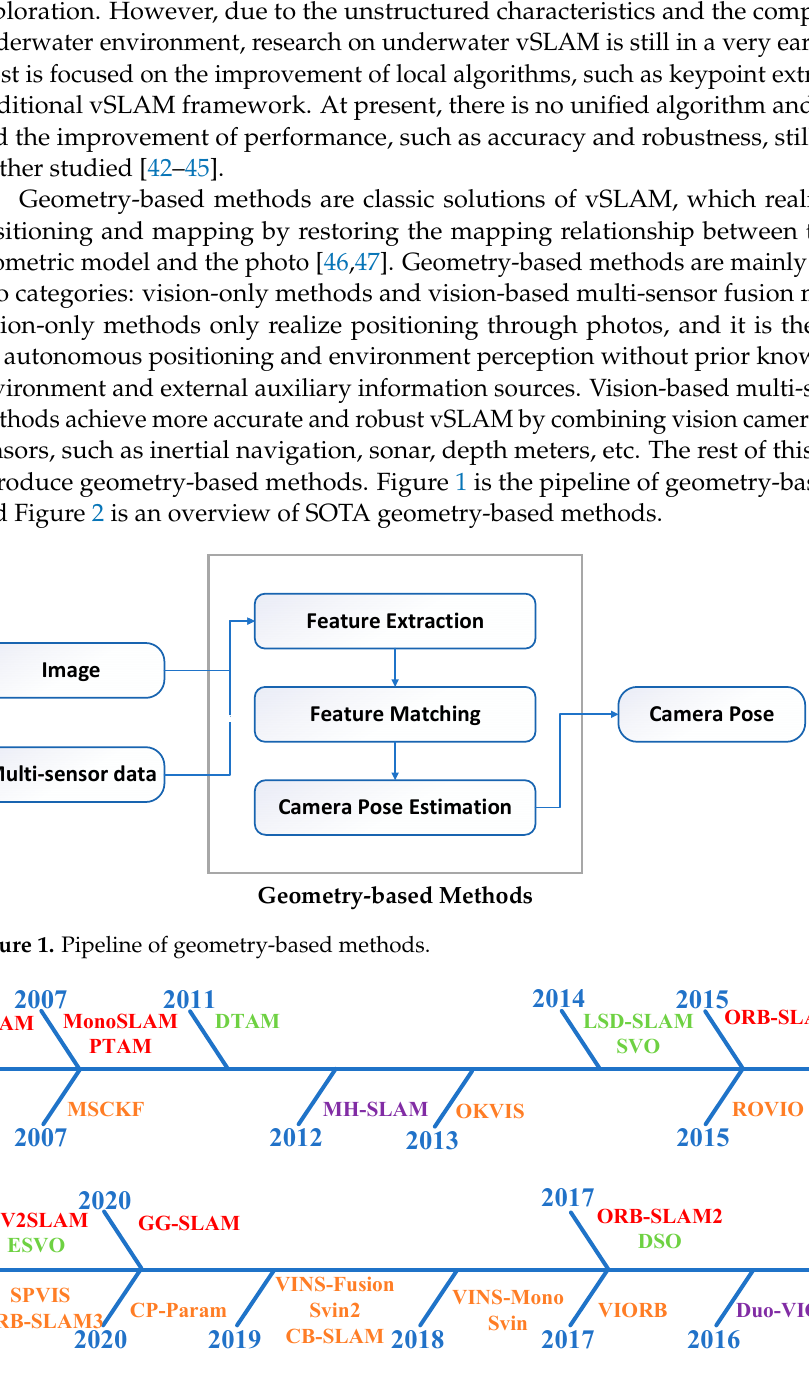
Figure 2. Overview of SOTA geometry-based methods. The ones above the timeline represent vision-only methods, with feature-based methods in red and direct methods in green. Those below the timeline represents vision-based multi-sensor fusion methods, where purple represents loosely- coupled and orange represents tightly-coupled.